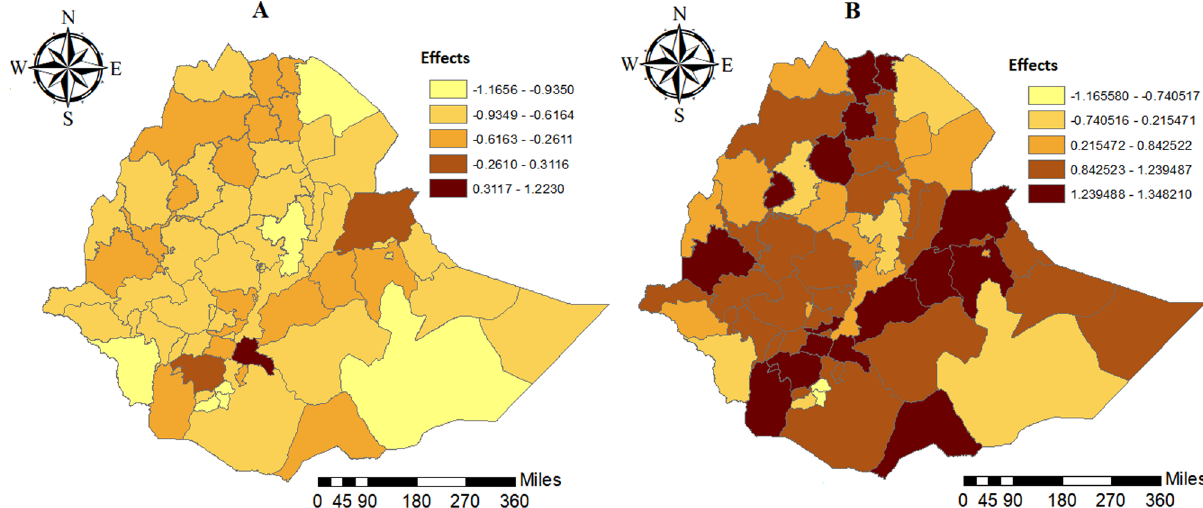
Figure 3. Estimated mean effect: ( A ) unstructured spatial effect; ( B ) the structured spatial effect.